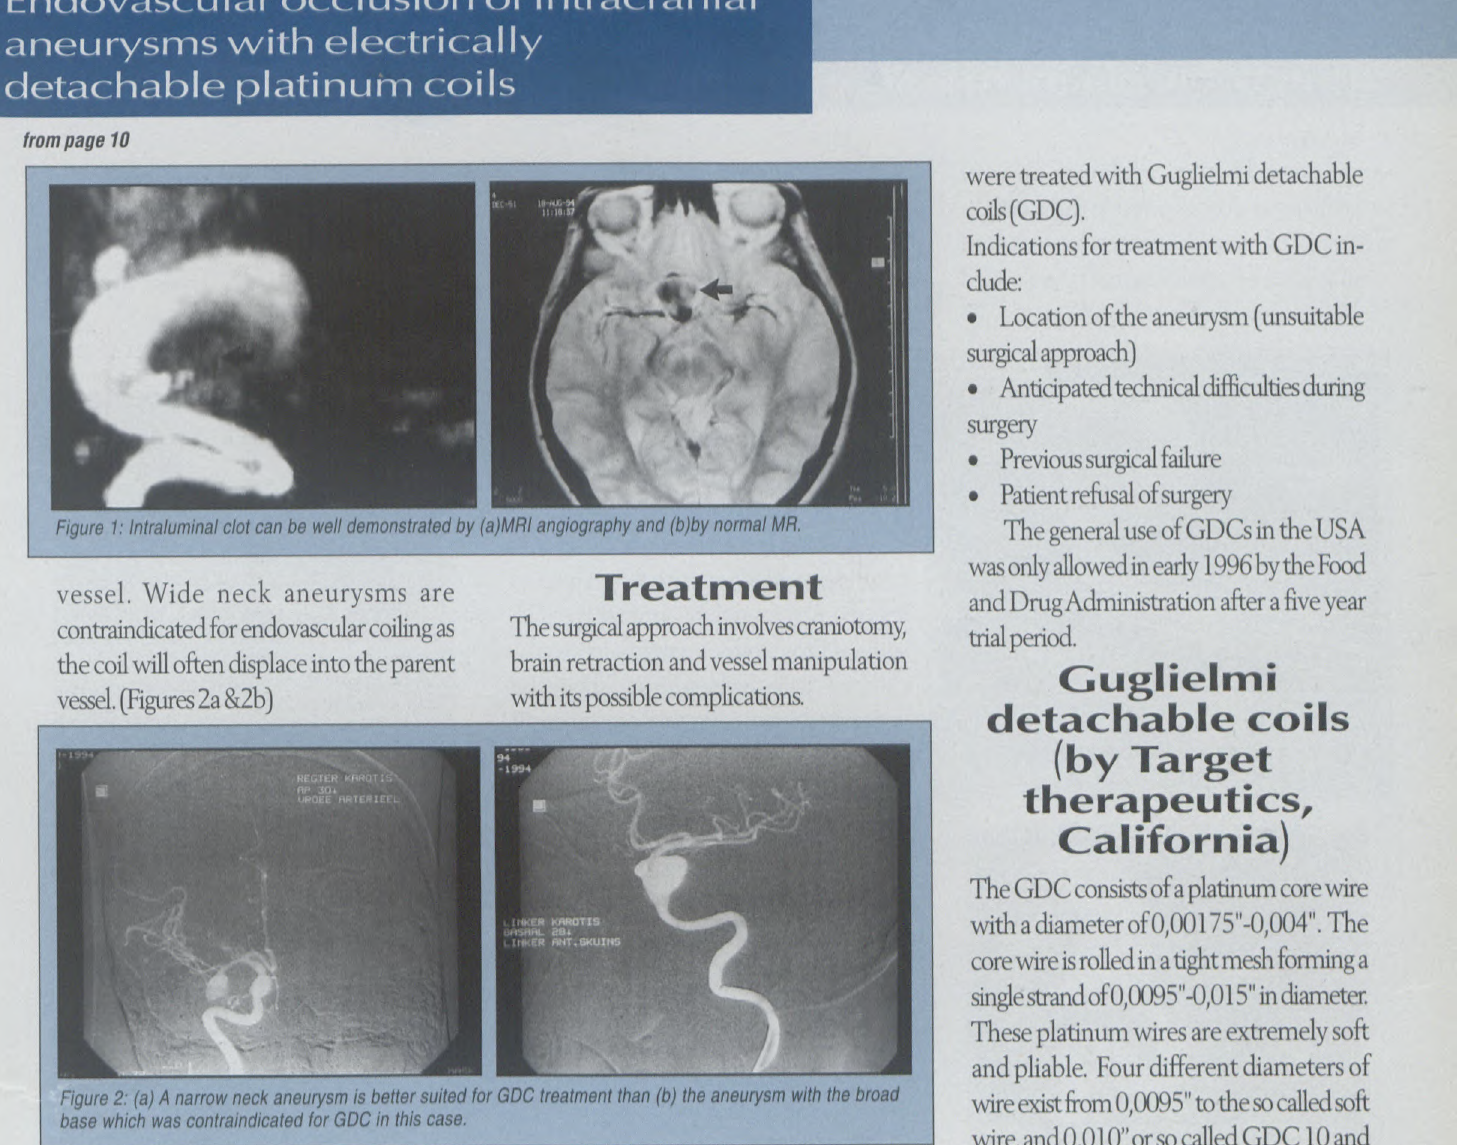
Figure 2: (a) A narrow neck aneurysm is better suited for GOG treatment than (b) the aneurysm with the broad base which was contraindicated for GOG in this case.